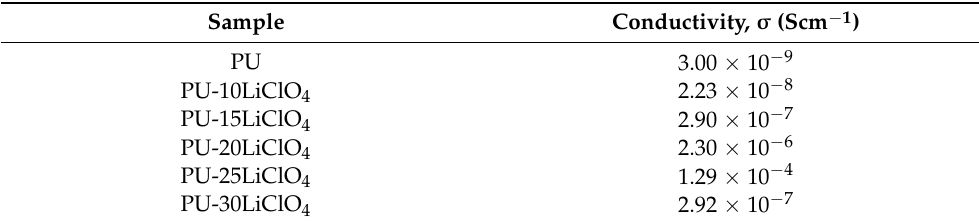
Table 3. Ionic conductivity of various wt.% of LiClO 4 in PU polymer